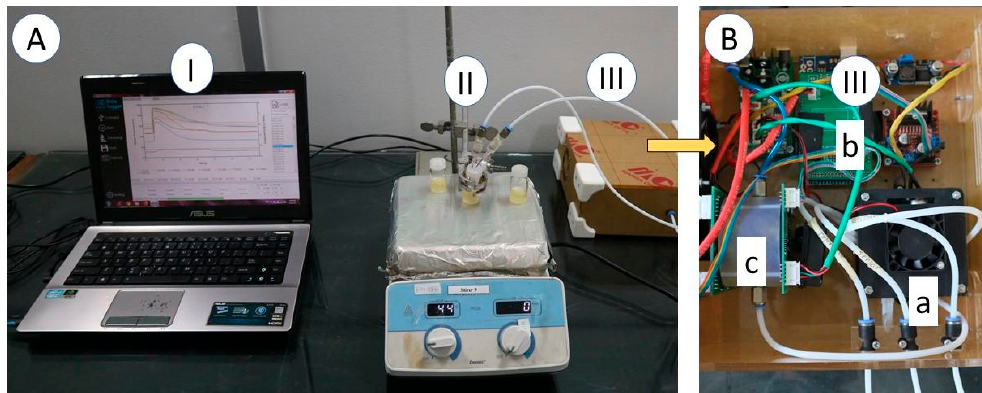
Figure 1. ( A ) E ‐ nose measurement set ‐ up. I: a personal computer with a software of DAQ and chemometric models, II: sample on the hot plate, and III: the main part of e ‐ nose; ( B ) III: main part of electronic nose device. a: sampling system, b: DAQ and controller, c: sensor chamber.